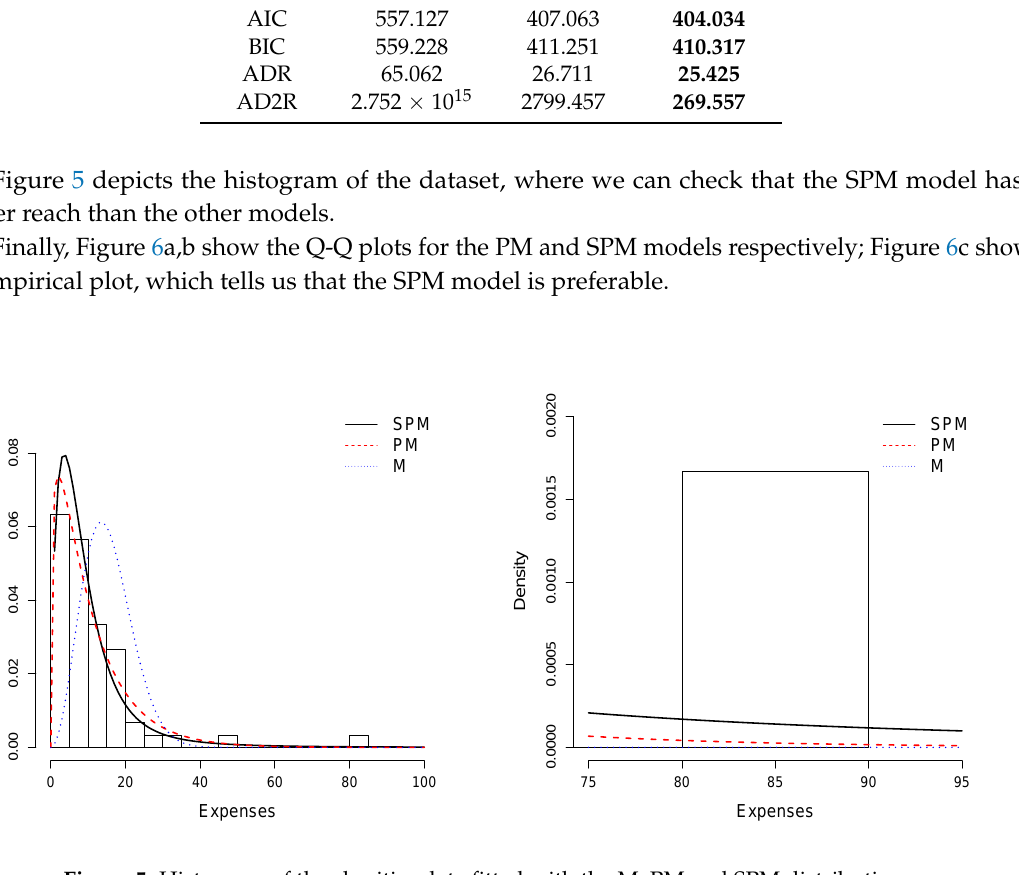
Figure 5. Histogram of the charities data fitted with the M, PM and SPM